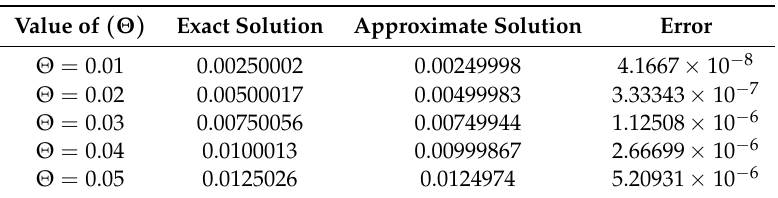
Table 1. Representation of the discussion amidst exact solution (Equation (91)) and approximate solution (Equation (104)) with different value of ( Θ )